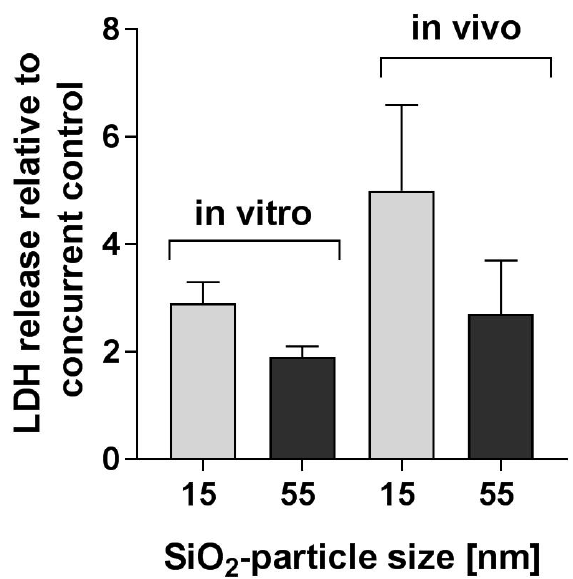
Figure 4. Comparison of in vitro LDH release (NR8383 assay) and in vivo LDH release (rat intratracheal instillation study) elicited by 15 nm and 55 nm SiO 2 . In vitro LDH release was elicited by 45 µg/mL of